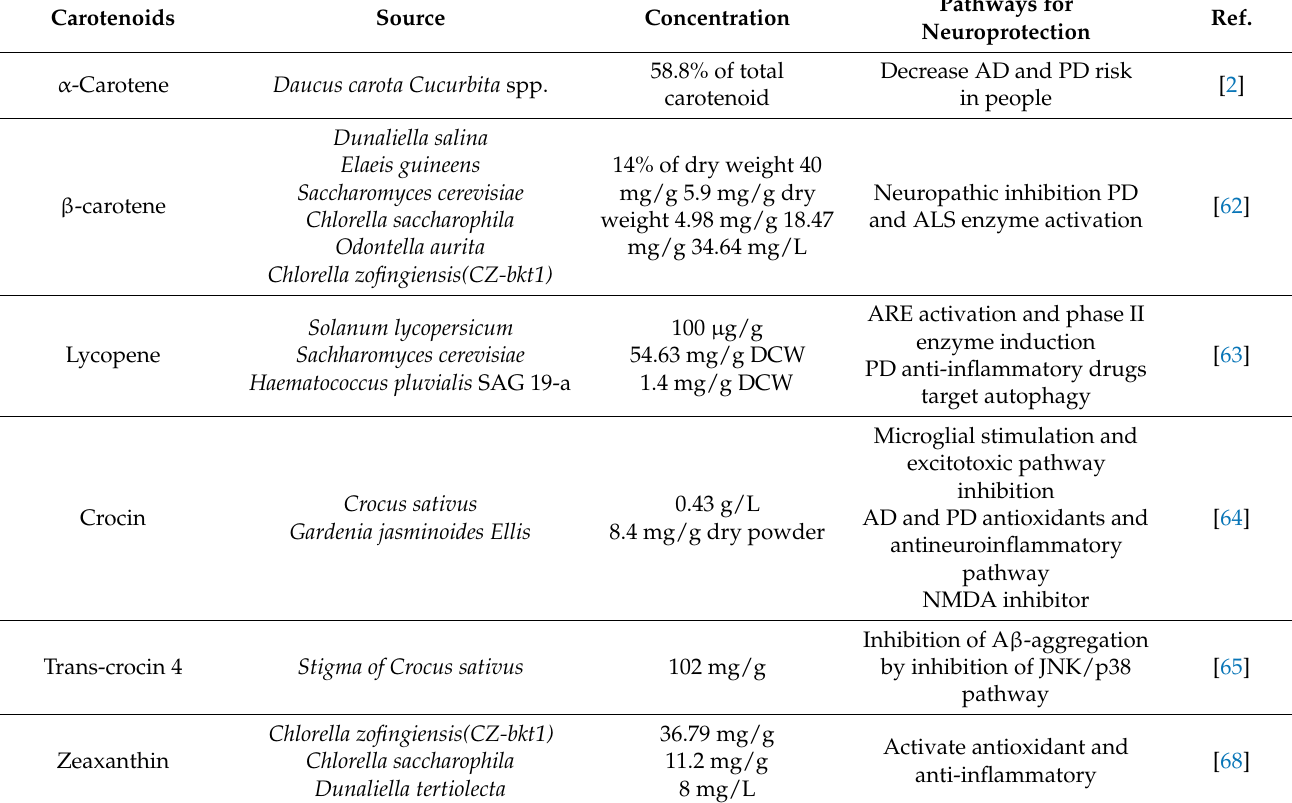
Table 2. Carotenoids, their representative high-yield sources, and their structures, coupled with the NDs pathways that they